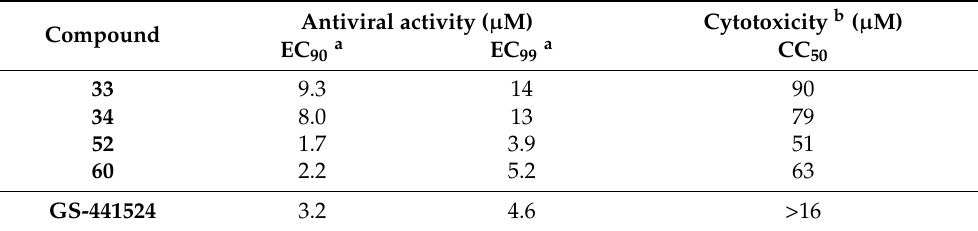
Figure 2. Inhibition of SARS-CoV-2 replication in A549-AT cells. ( A ) reduction in viral load in the supernatant at day 3 p.i. ( B ) compound cytotoxicity based on MTS cell viability assay in mock-infected cells. Data points are the mean ± SEM (N = 3). Reference compound: GS-441524, the nucleoside form of remdesivir. Table 2. Anti-SARS-CoV-2 activity of selected 1,4,4-trisubstituted piperidine